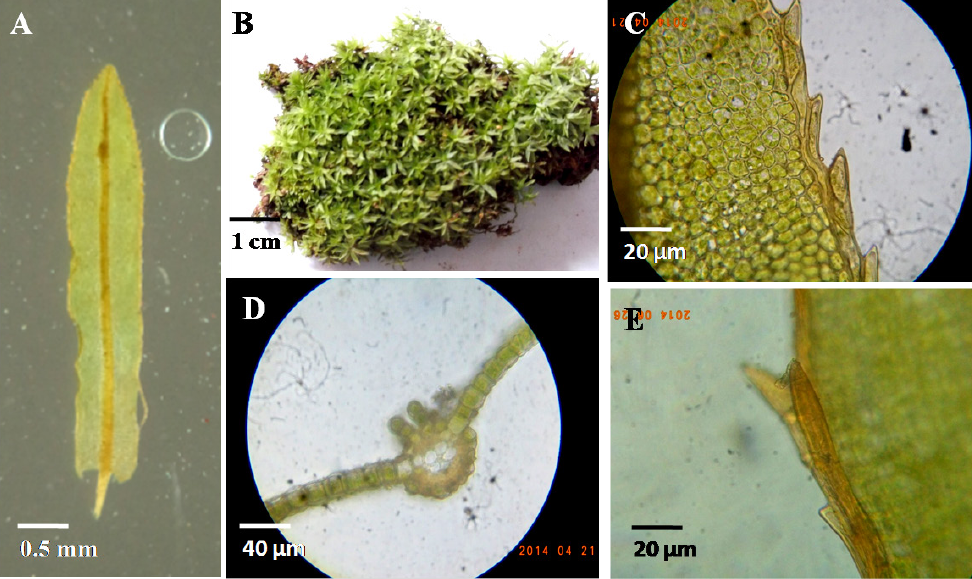
Figure 3: General morphology of Atrichum ( A. crispulum ) (A) vegetative leaf (B) gametophytes of without sporophytes (C) leaf margin, (D) transverse section of a leaf, (E) leaf marginal